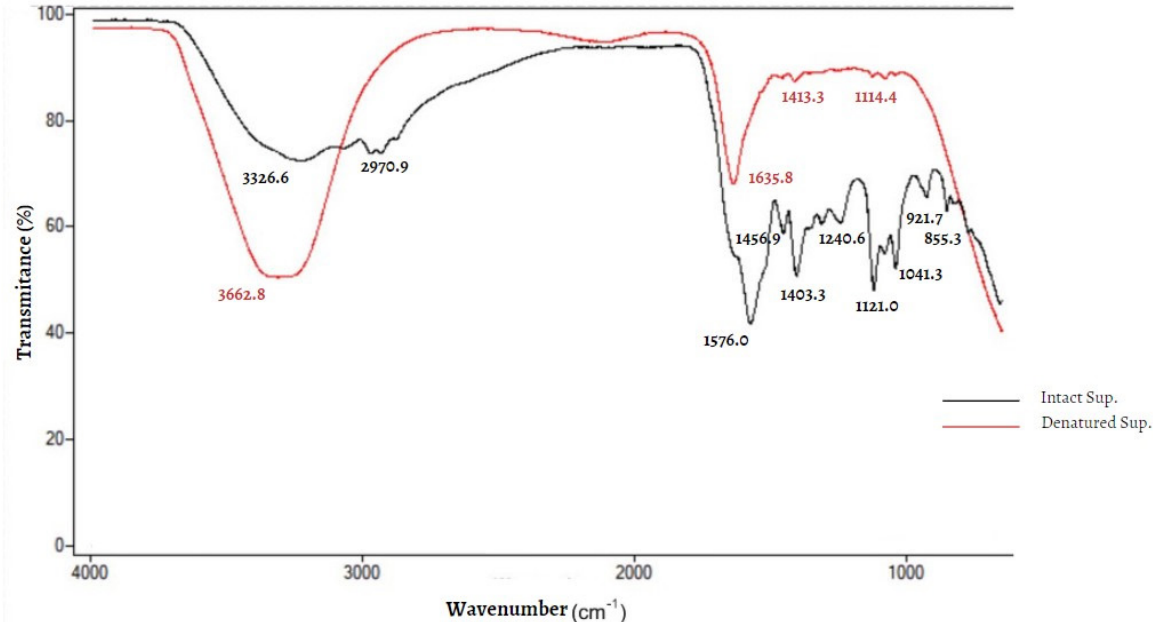
Figure 4. Fourier transform infrared spectroscopy with attenuated total reflectance (FTIR-ATR) of the intact and denatured supernatant of Lactiplantibacillus plantarum